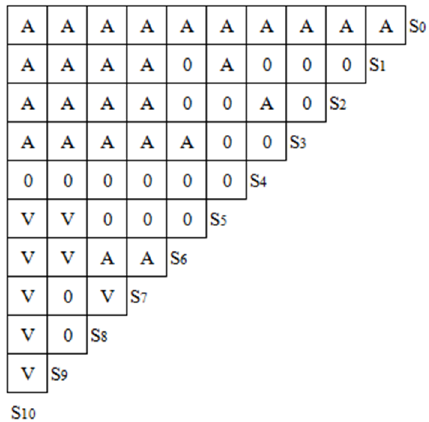
Figure 2. Logical Relationship Among Influencing Factors of Feeding Rationalization. The adjacency matrix B is determined according to Figure 2 and Formula (7), and the accessibility matrix M is obtained according to Formula (8) using Matlab7.11